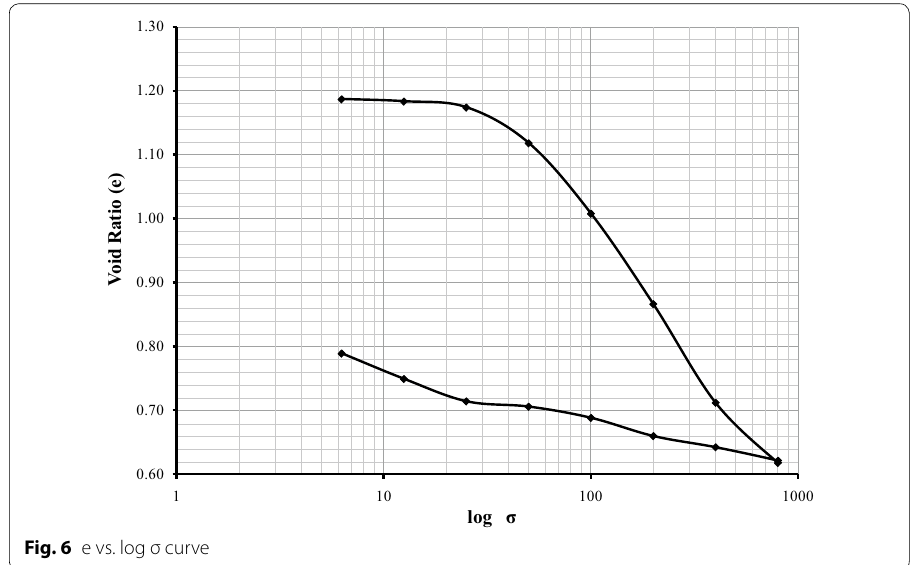
Fig. 6 e vs. log σ